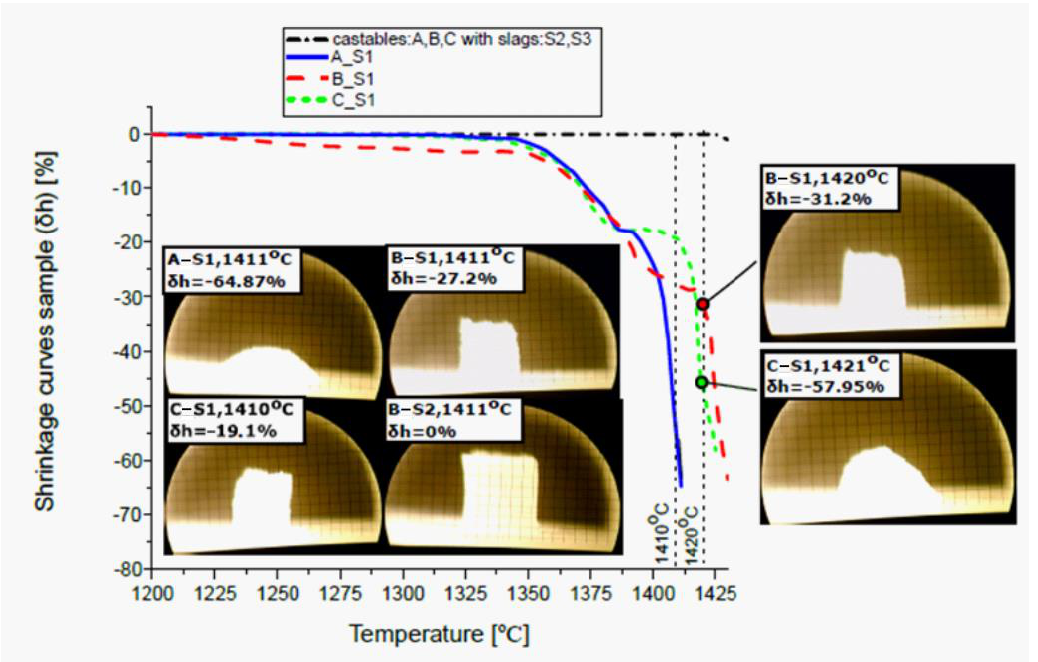
Figure 8. Shrinkage curves of castable compositions (A, B, and C) with slags (S1, S2, and S3) versus increasing temperature.